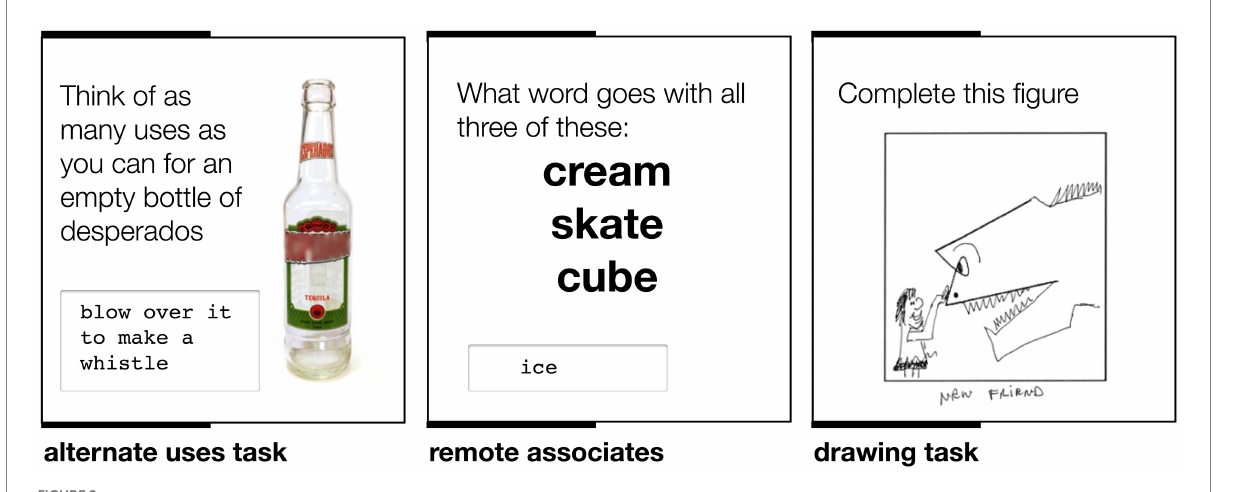
FIGURE 2 Schematic of creativity task, with example